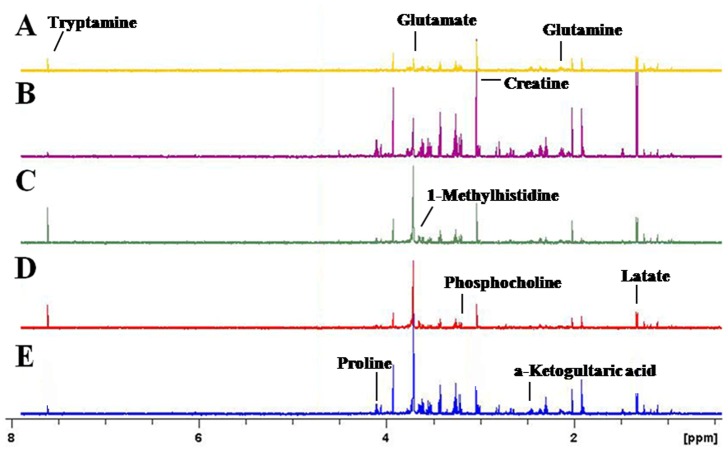
600 MHz CPMG 1HNMR spectra of the NAc from mice.(A) control; (B) 2 mg/kg cocaine; (C) 20 mg/kg cocaine; (D) nicotine; (E) nicotine +2 mg/kg cocaine.